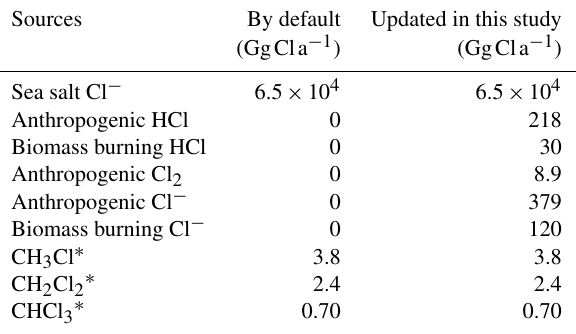
Table 1. Chlorine emissions in China in the model. Sources By